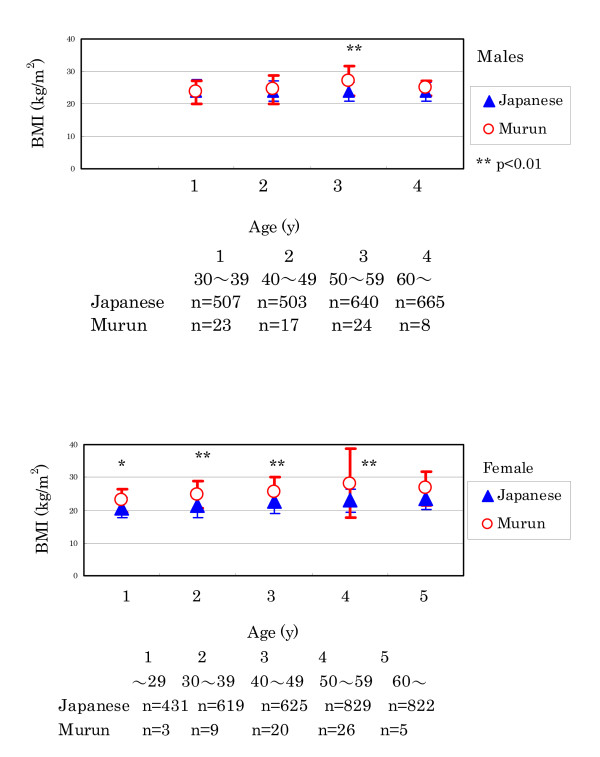
Comparison of BMI between Murun subjects and Japanese people. Murun subjects showed higher BMI levels than age-matched Japanese people. In males, the difference became clear in those over aged 50.